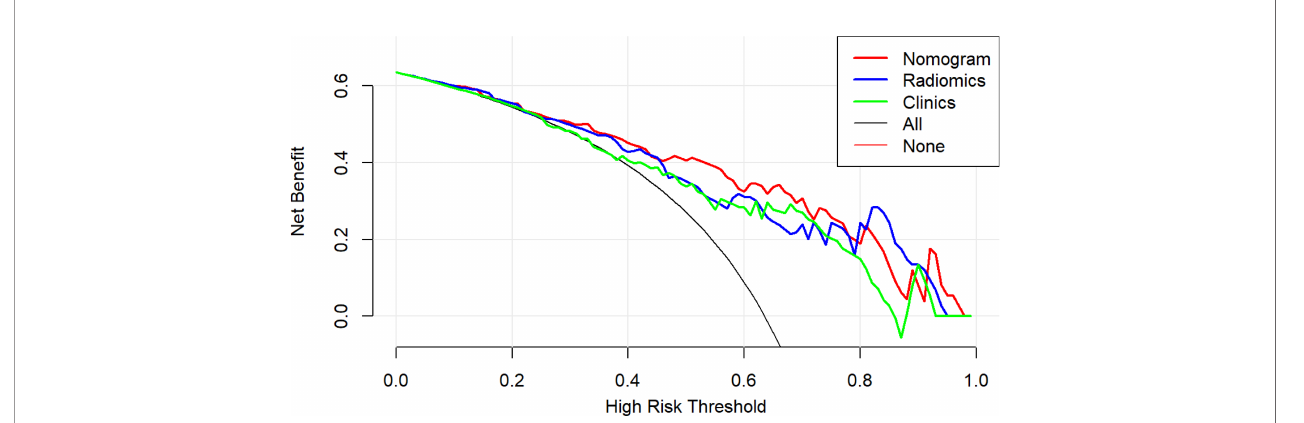
FIGURE 6 | Decision curve analysis (DCA) results for the three discrimination models. The Y-axis represents the net bene fi t, calculated by summing the bene fi ts (true-positives) and subtracting the weighted harm (i.e., deleting false-positives). The optimal method for feature selection is that with the highest net bene